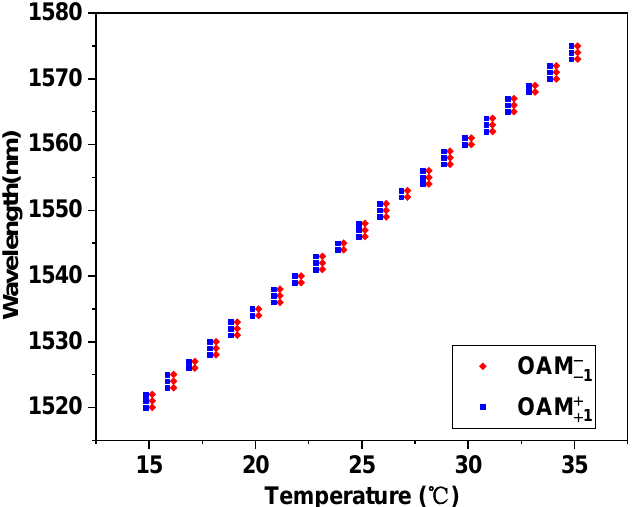
Figure 9. The variations in coupling wavelengths as temperature changes for different modes.